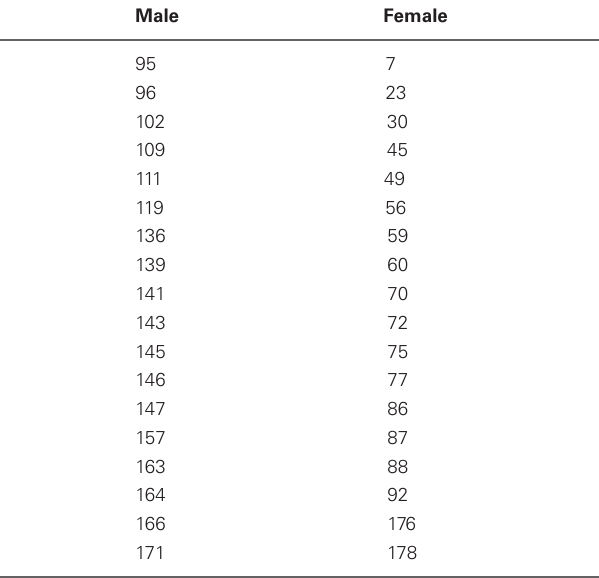
Table 2 | Reference numbers to faces taken from the Facial Action Coding System Generator (FACSGen: Roesch et al.,